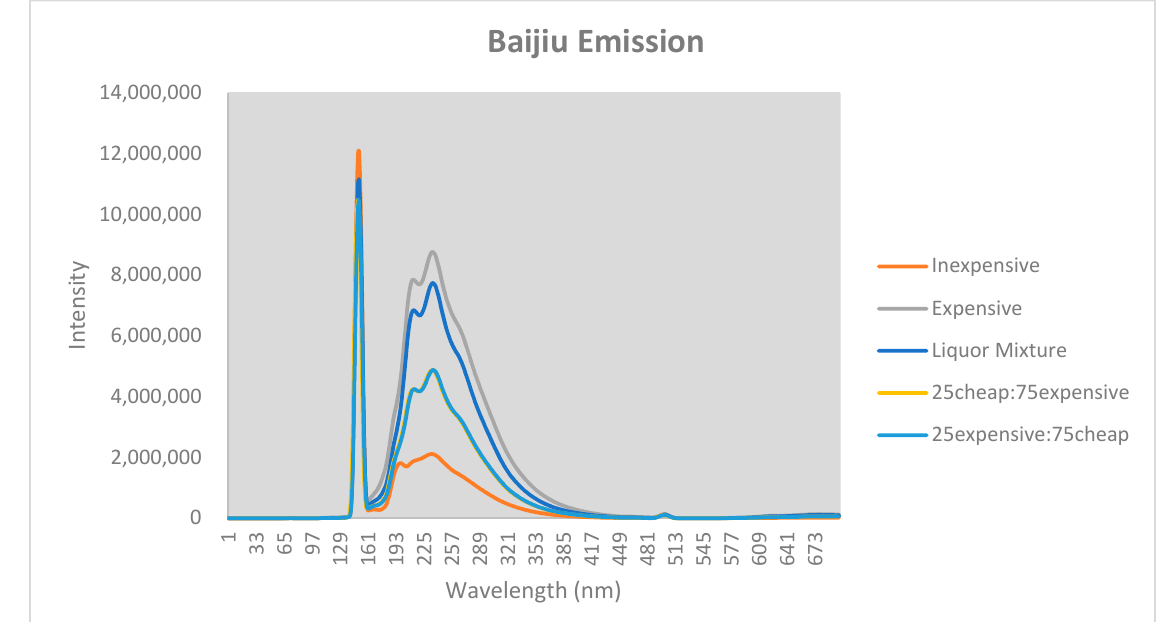
Figure 5. Moutai emission of different ratios of inexpensive to expensive baijiu spirits.